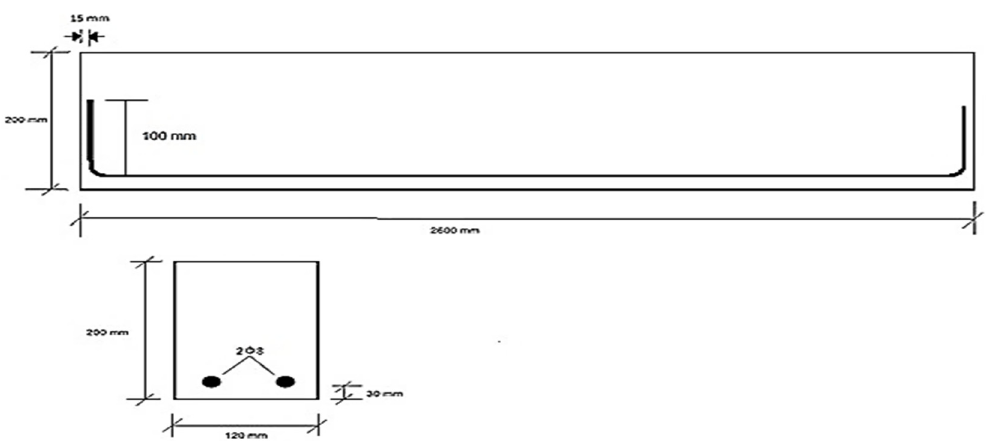
Figure 7. Details of reinforcement arrangement in SRC beams. Table 3. Characteristics of tested beams.